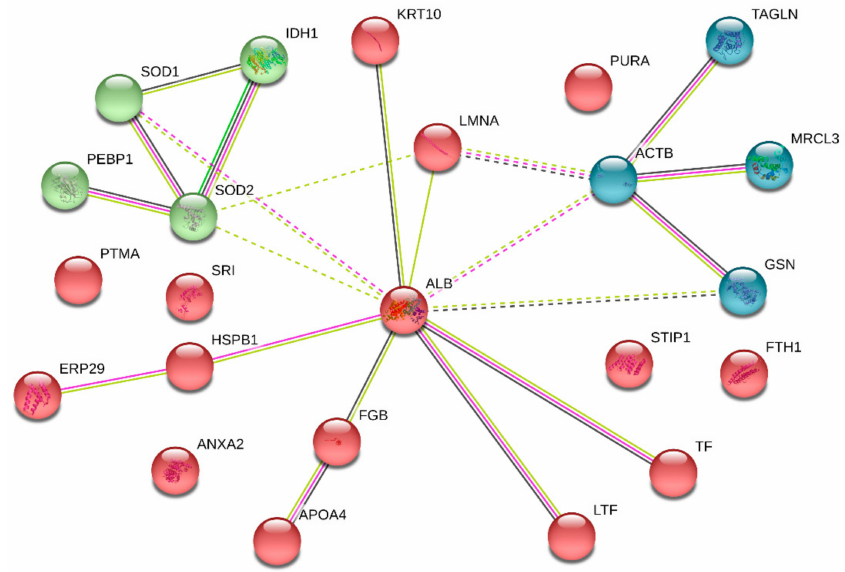
Figure 5. PPI network analysis of DEPs in CMMTs. The nodes represent proteins, and the edges represent the predicted functional associations. The green line represents neighboring evidence, the purple line represents experimental evidence, the yellow line represents textual evidence, and the black line represents co-expressive evidence. CMMTs, mammary tissues with clinical mastitis. DEPs, di ff erentially expressed proteins.